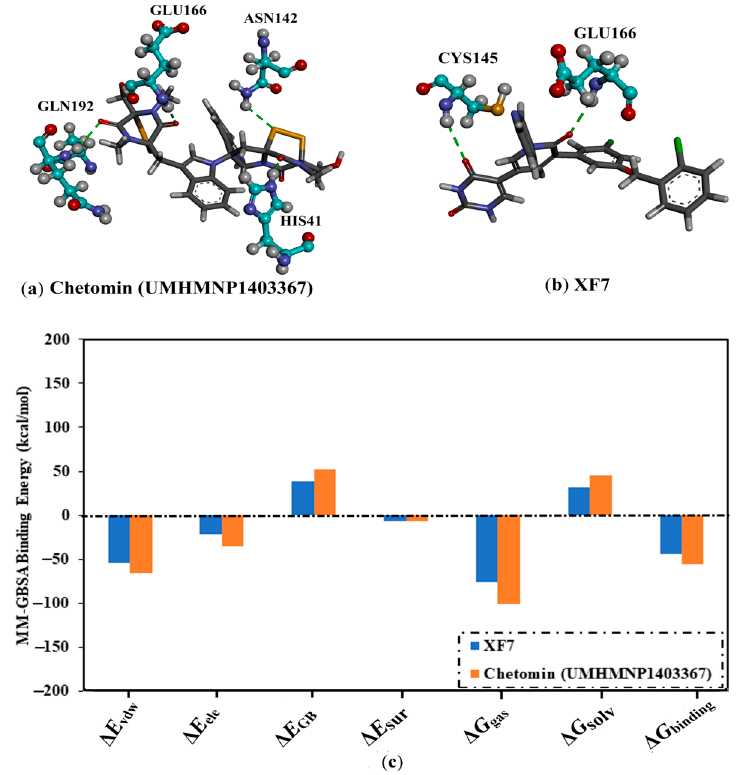
Figure 5. 3D molecular interaction pattern of binding modes of ( a ) chetomin and ( b ) XF7 complexed with 3CL pro based on the average structure, and ( c ) components of the MM-GBSA binding energies throughout the MD course of 200 ns.